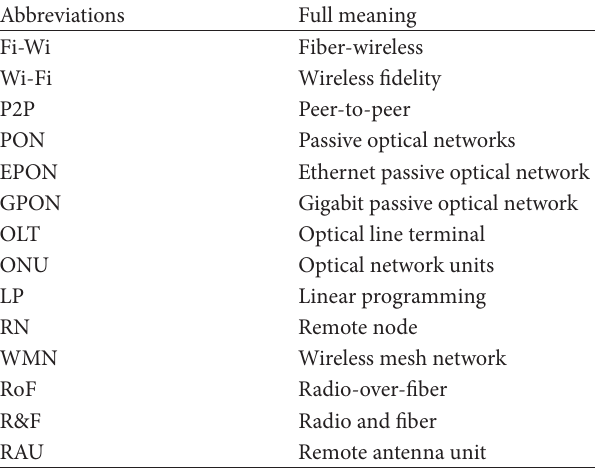
Table 1: Major terminologies at a